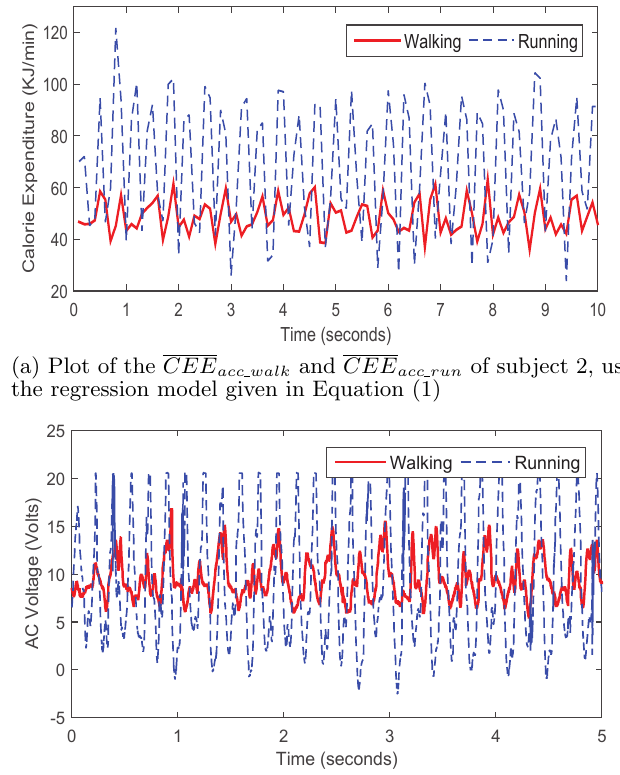
Walking Running